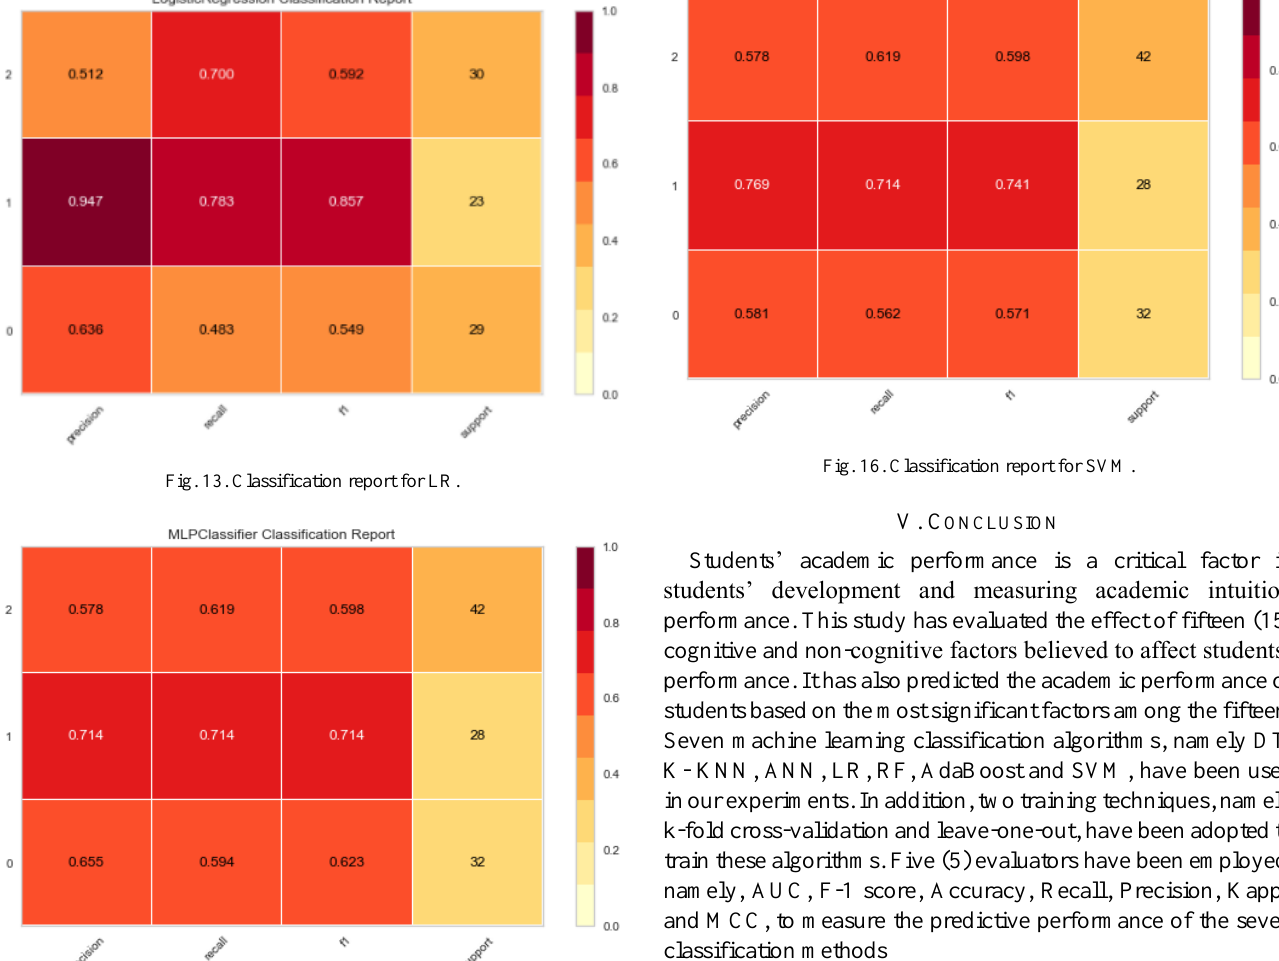
Fig. 14. Classification report for MLP.